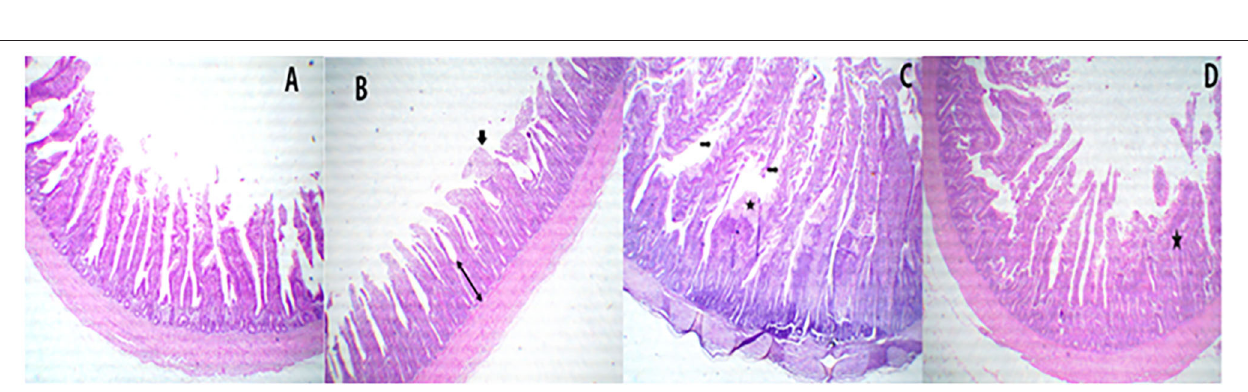
FIGURE 2 | A representative photomicrograph of 40 × magnification H&E stained small intestine sections of the broiler chickens. The sections from the duodenal segments from PROE0group showed separate tall and arranged intestinal villi with (arrow) free lumen (A) , the duodenal segments from PROE1 group showed apparently separated tall and arranged intestinal villi with free lumen (B) , the duodenal segments from PROE2 group revealed marked active intestinal villi and crypts which characterized by limited goblet cells metaplasia (star)’ increased sizes and rows of enterocytes (thick arrow) with arranged lamina propria beside some desquamated villi (small arrow) (C) . Chicken fed on PROE3 diet revealed marked thin, tall, and separate villi with mild goblet cell proliferations (star) (D) .